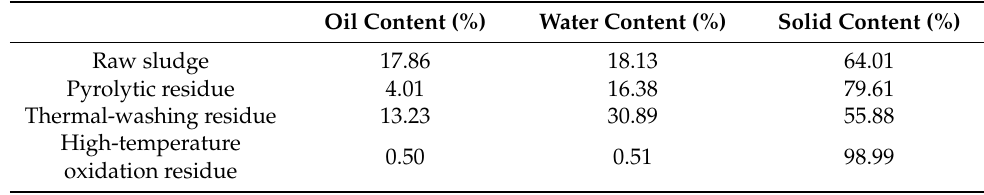
Table 2. Physicochemical properties of raw sludge and prepared residues.